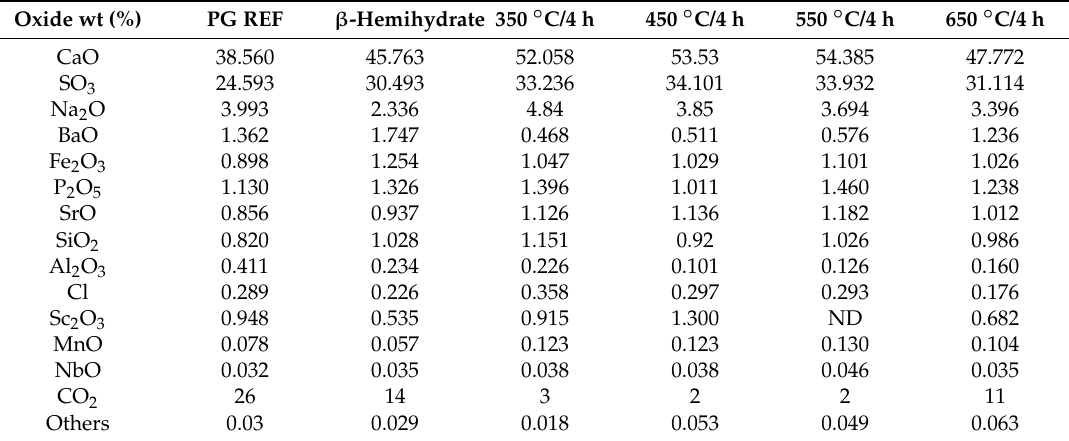
Table 2. Chemical analysis of dried phosphogypsum (PG REF), β -hemihydrate and phosphoanhydrite